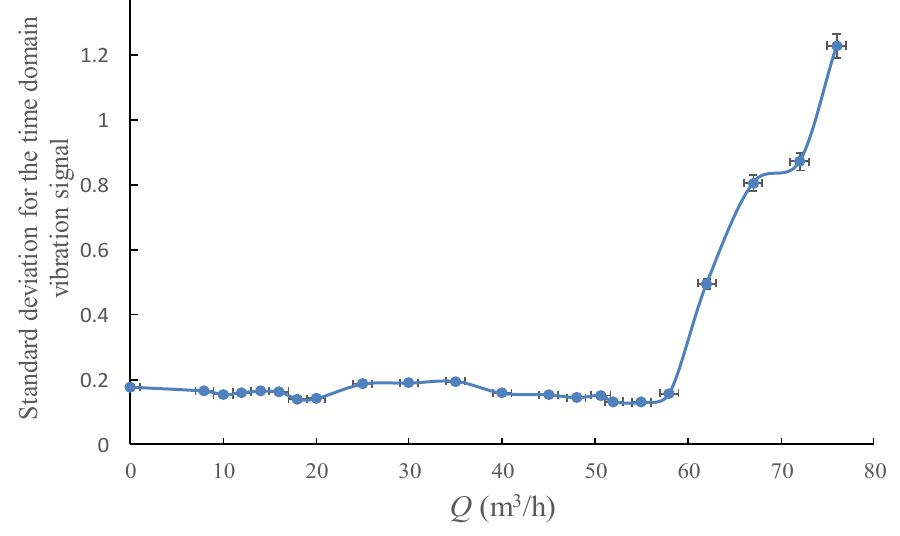
Figure 12. Standard deviation for the time domain vibration signal under different flowrates.